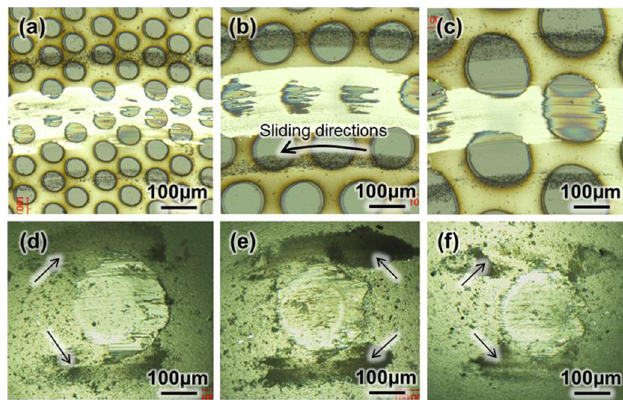
Fig. 15. Optical surface images of wear tracks of micro-textured DLC fi lms with different texture diameters of 50 m m (a), 100 m m (b), 150 m m (c) as well as the corresponding counterparts of alumina balls (d – f), respectively, after the ball-on-disk friction